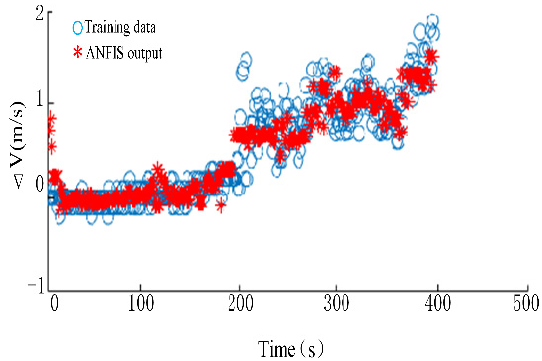
Figure 9. Comparison chart of training data and ANFIS output.